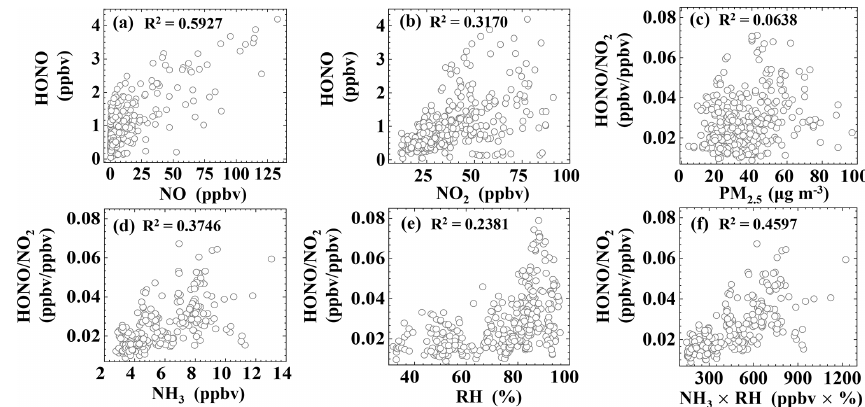
Figure 4. Correlations between HONO, HONO / NO 2 , and various parameters during the time interval of 18:00–06:00.